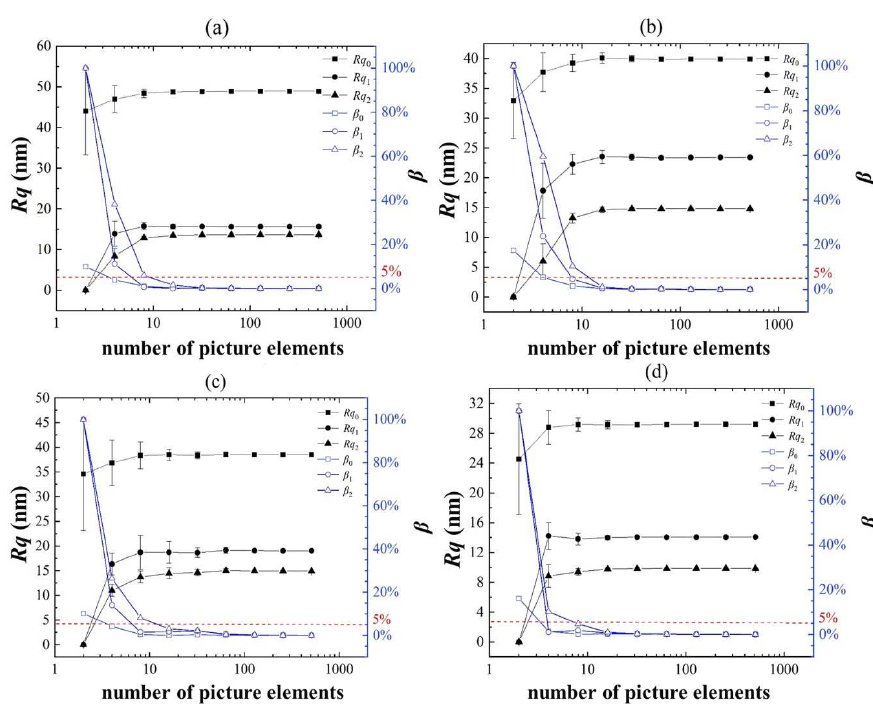
Figure 7. Rq values obtained by using different number of picture elements and flatten orders for the surfaces of a silver thin film. The subfigures ( a – d ) represented four different positions randomly selected on the surface, respectively.